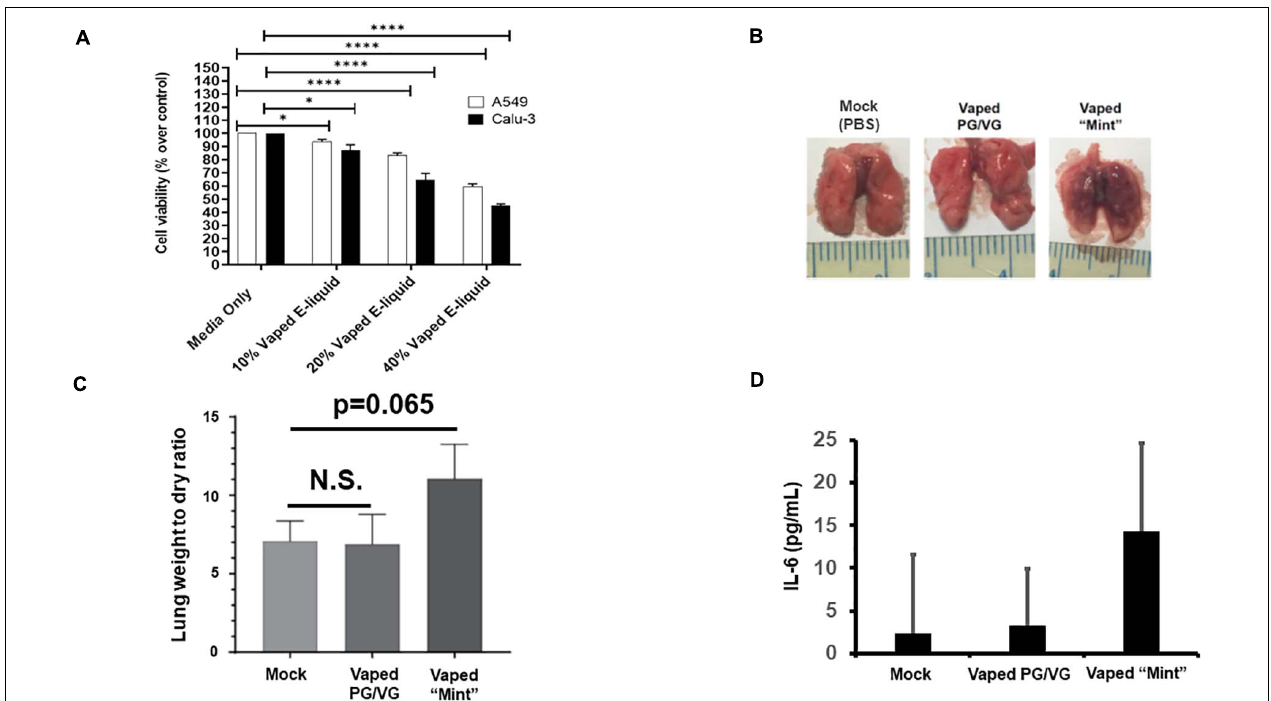
FIGURE 1 | Acute in vitro and in vivo models of vaping indicate cytotoxicity and pro-inflammatory responses. (A) A549 (2.0 × 10 4 ) and CALU-3 (3.0 × 10 4 ) cells were plated overnight in 96-well plates. Vaped e-liquids were added at the indicated concentrations (vol/vol) in complete medium. The plates were then incubated for 24 h, stained for viability, and read using a PHERAstar plate reader. Media-only mock control treatments were also performed. n = 18–24 wells per pretreatment. (B) Mice [four mice (two males and two females)/ group] received either PBS (mock), vaped PG/VG vehicle, or vaped “Mint” e-liquid (10 µ l, containing ∼ 20 µ g of nicotine) once daily intranasal (IN) for 3 days and were then sacrificed on the 4th day. Representative macroscopic images of dissected lungs are displayed. (C) Lung wet/dry weight ratios of mice receiving either PBS (mock), vaped PG/VG vehicle, or vaped e-liquid. n = 4 mice (two males and two females) per treatment